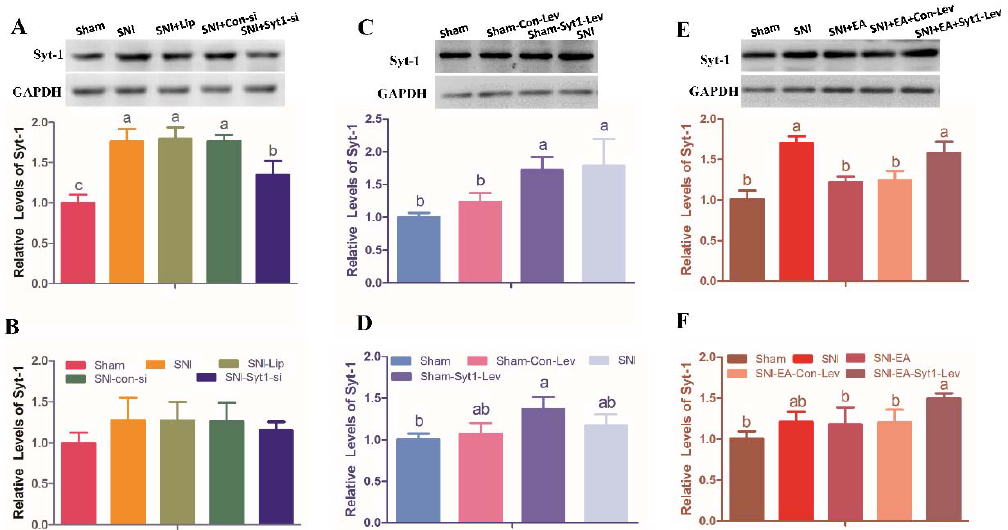
Figure 4. The e ff ect of Syt-1 knockdown, Syt-1 overexpression or EA stimulations on Syt-1 expression (Mean ± SD, n = 6). ( A , B ) Syt-1 mRNA and protein levels were detected at day 20. Intrathecal Figure 4. The effect of Syt ‐ 1 knockdown, Syt ‐ 1 overexpression or EA stimulations on Syt ‐ 1 expression injection of Syt-1 siRNA after SNI treatment decreased the protein of Syt-1, but unchanged its mRNA. (Mean ± SD, n = 6). A, B Syt ‐ 1 mRNA and protein levels were detected at day 20. Intrathecal injection ( C , D ) Intrathecal injection of Syt-1 activation particles shows the similar tendency of Syt-1 protein of Syt ‐ 1 siRNA after SNI treatment decreased the protein of Syt ‐ 1, but unchanged its mRNA. C, D as SNI surgery. The mRNA and protein levels of Syt-1 in Sham-Syt1-Lev rats were higher than those in Intrathecal injection of Syt ‐ 1 activation particles shows the similar tendency of Syt ‐ 1 protein as SNI Sham group. ( E , F ) Rats in SNI-EA group showed decreased Syt-1 protein levels compared with rats surgery. The mRNA and protein levels of Syt ‐ 1 in Sham ‐ Syt1 ‐ Lev rats were higher than those in Sham in SNI group. Intrathecal injection of Syt-1 lentiviral activation particles induced an increase in Syt-1 group. E, F Rats in SNI ‐ EA group showed decreased Syt ‐ 1 protein levels compared with rats in SNI protein and mRNA compared with EA treatment. No change was observed in Syt-1 mRNA among group. Intrathecal injection of Syt ‐ 1 lentiviral activation particles induced an increase in Syt ‐ 1 protein Sham, SNI, SNI-EA and SNI-Con-Lev groups. A, C, and D shows Syt-1 protein; B, E and F shows Syt-1 and mRNA compared with EA treatment. No change was observed in Syt ‐ 1 mRNA among Sham, mRNA. Values with di ff erent letters (a, b and c) at the same day show di ff erent ( p < 0.05); one-way SNI, SNI ‐ EA and SNI ‐ Con ‐ Lev groups. A, C, and D shows Syt ‐ 1 protein; B, E and F shows Syt ‐ 1 ANOVA followed by Bonferroni mRNA. Values with different letters (a, b and c) at the same day show different ( p < 0.05); one ‐ way ANOVA followed by Bonferroni test.